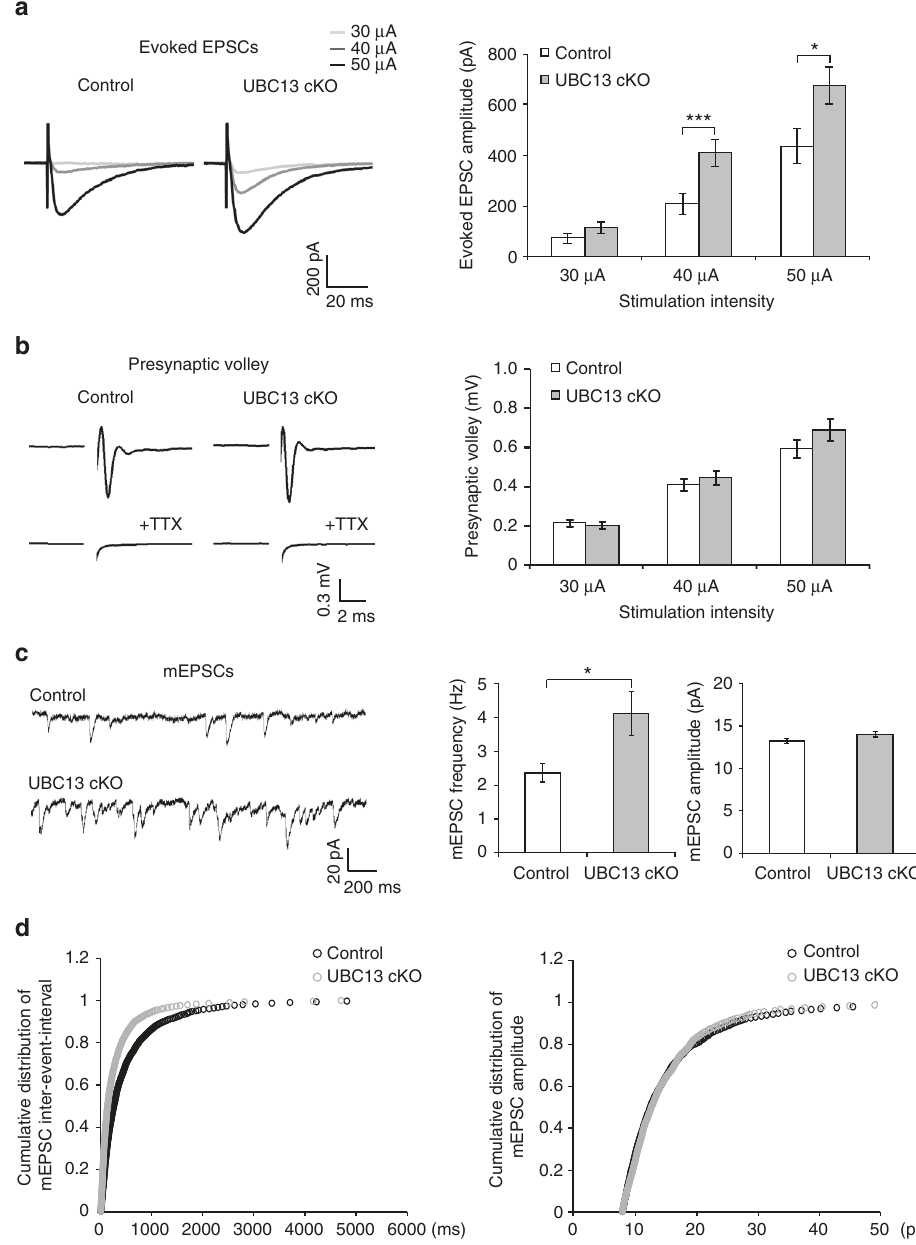
Fig. 5 UBC13 suppresses granule neuron to Purkinje cell neurotransmission in the cerebellum. a Acute sagittal cerebellar slices from P23 – 26 UBC13 cKO and control mice were subjected to electrophysiological analyses. Evoked excitatory postsynaptic currents (EPSCs) were recorded in Purkinje neurons in response to stimulation of parallel fi bers with increasing intensity (30, 40, and 50 μ A). Representative current traces (left) and quanti fi cation of the amplitude of evoked EPSCs (right) are shown. The amplitude of evoked EPSCs in Purkinje neurons was increased in UBC13 cKO mice compared to control mice (*** p < 0.005 at 40 μ A, * p < 0.05 at 50 μ A, ANOVA followed by Fisher ’ s PLSD post hoc test, n = 25 – 29, six mice). b Acute coronal cerebellar slices were prepared as in ( a ), and parallel fi ber axons were stimulated at sites 400 μ m away from an extracellular recording electrode. A representative trace of the stimulus-evoked presynaptic waveform before and after the application of tetrodotoxin is shown (left). The stimulus artifact was removed for clarity. On the right, quanti fi cation of presynaptic volley amplitude is shown. Conditional knockout of UBC13 had little or no effect on the presynaptic volley amplitude. c , d Acute sagittal cerebellar slices were prepared as in ( a ) and Purkinje cell mEPSCs were recorded. Representative traces of mEPSCs from UBC13 cKO mice and control mice are shown ( c , left). Quanti fi cation of the mean ( c , right) and cumulative distribution ( d ) of the mEPSC frequency and amplitude are shown. The frequency of mEPSCs was increased in UBC13 cKO mice compared to control mice (* p < 0.05, t test, n = 32 neurons, six mice). Conditional knockout of UBC13 had little or no effect on the amplitude of mEPSCs in Purkinje